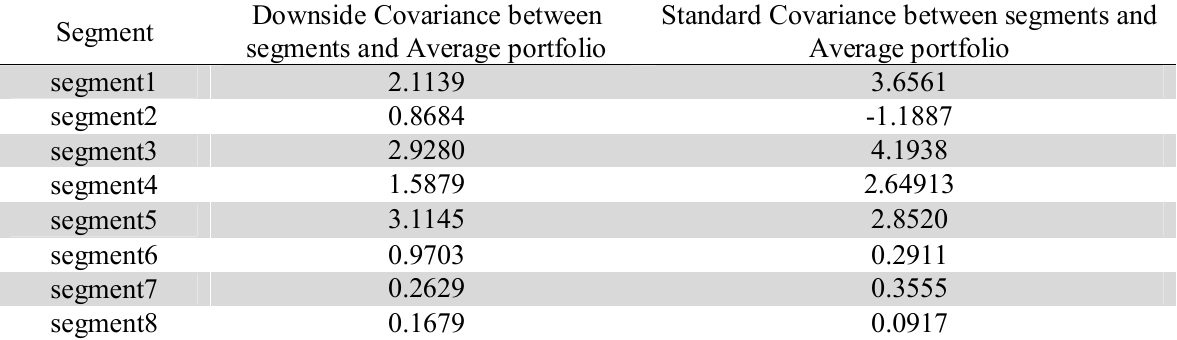
Standard Covariance versus Downside Covariance between Customer Segments and Average